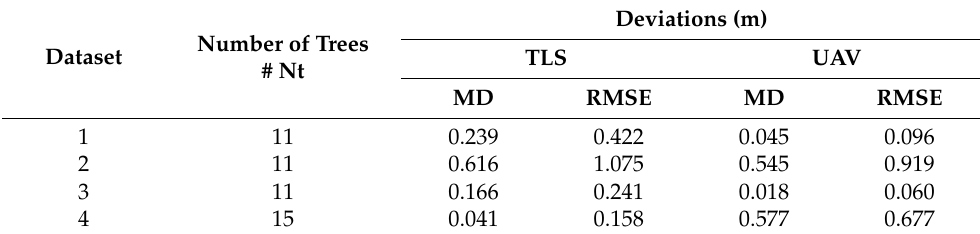
Table 7. Deviations in the tree heights. ‘# Nt’ represents the number of sample trees. The devi- ation was calculated as the distance between a tree height measured from the reference and the correspondence measured from the TLS data or UAV data. Deviations (m) Number of Trees Dataset TLS UAV # Nt MD RMSE MD RMSE